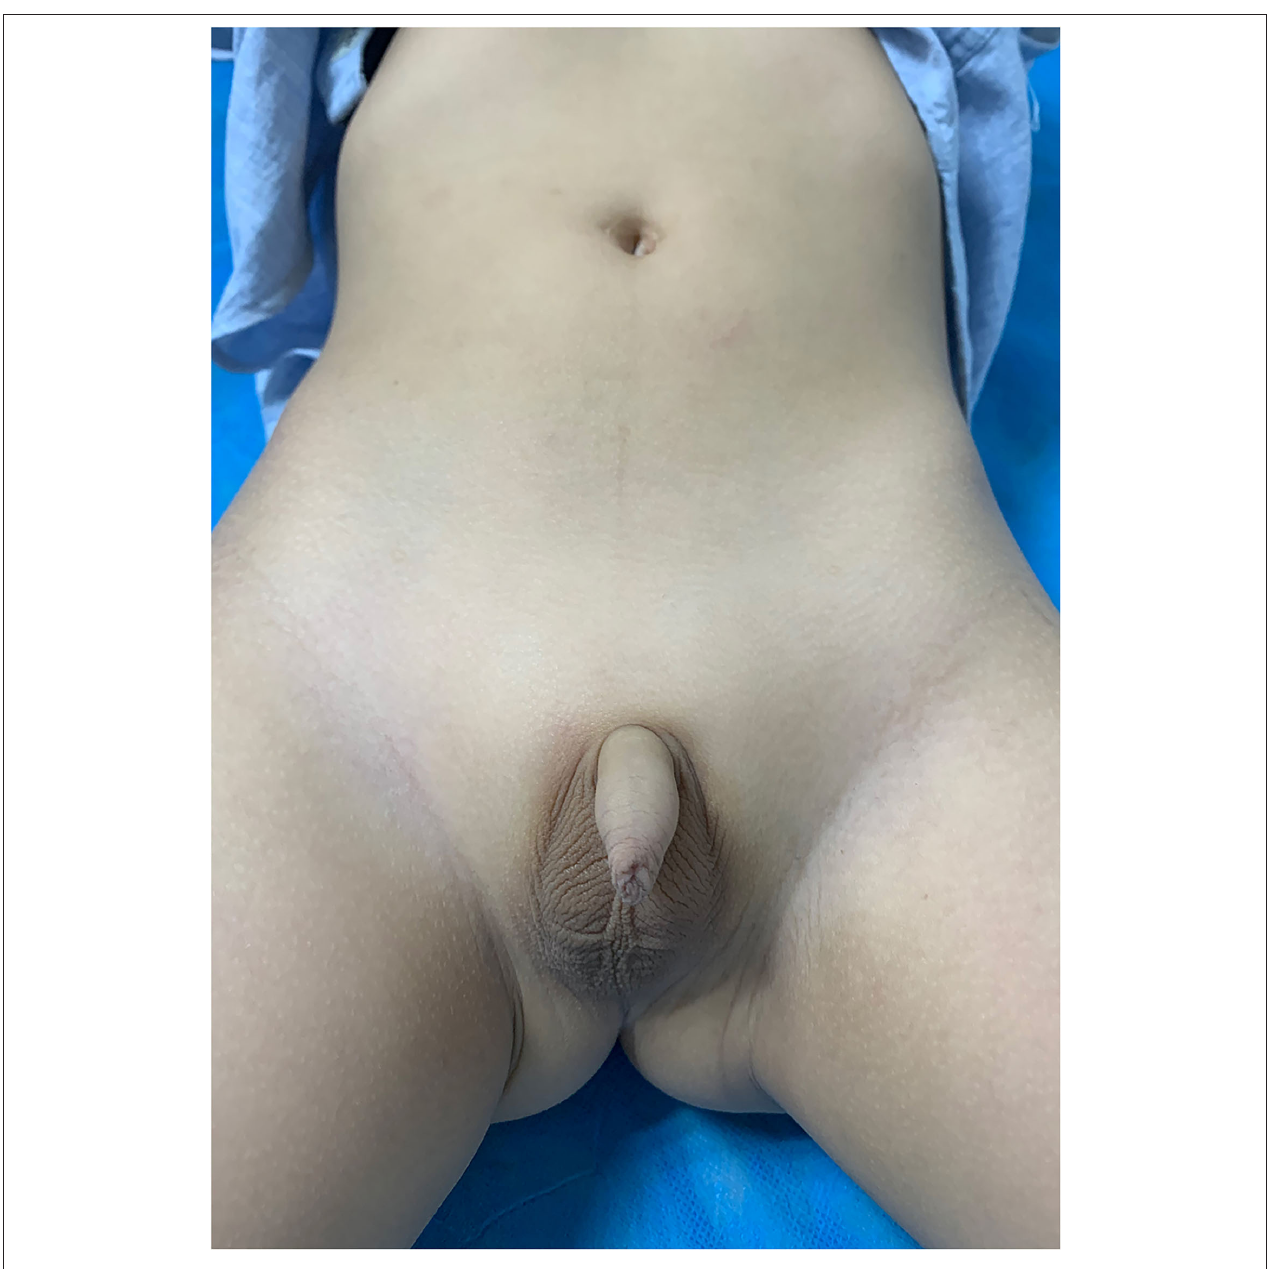
FIGURE 2 | Cosmetic result of a patient with bilateral UDT underwent LATO at the 12-month follow-up.